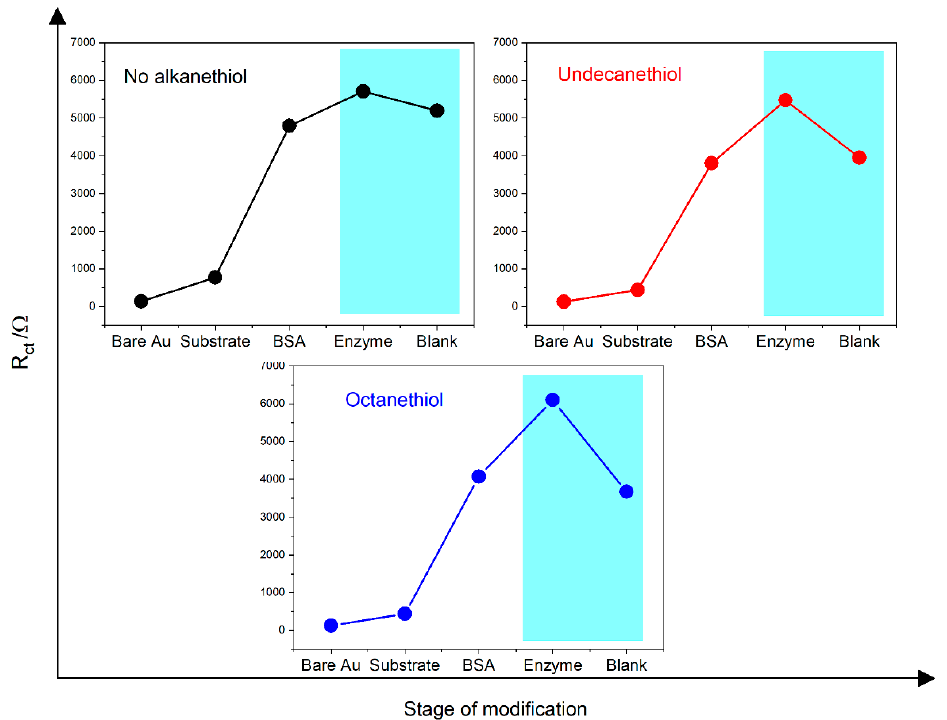
Figure 6. Charge-transfer resistance changes depending on the alkanethiol used in particular stages of the research. The blue area shows electrodes incubated according to the described procedure, with and without enzyme.